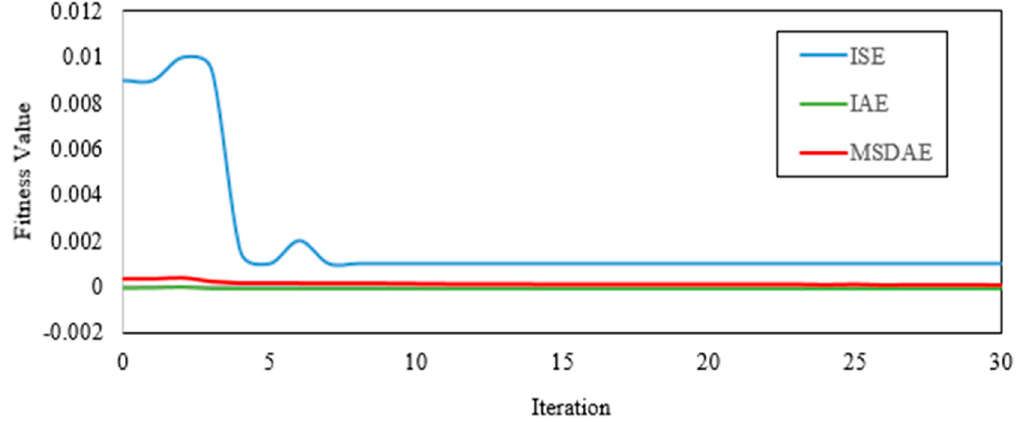
Figure 3. Fitness functions vs. iteration number for linear contour.